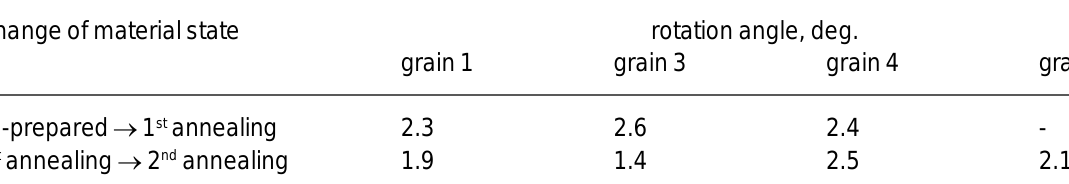
Table 2. Grain rotation after the first and the second anneals. Change of material